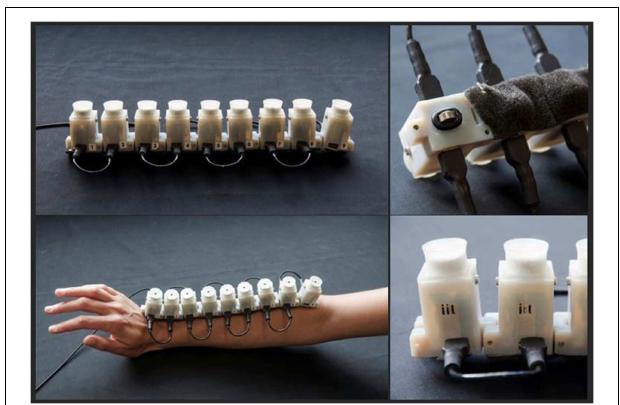
FIGURE 1 | Images from the device used during the test. It is composed by 9 units constituted by a speaker and a vibrating motor individually controllable. Units were separated by 3.5cm. The device was located on the forearm, with the the 1st unit close to the hand and the 9th unit close to